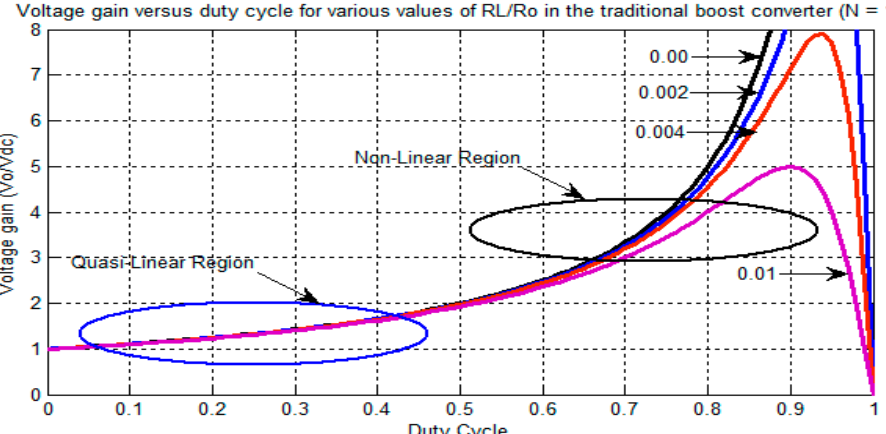
Figure 3. Duty cycle versus voltage gain of a traditional boost converter for various values of R L / Ro ( N = 1). Electronics 2018 , 7 , x FOR PEER REVIEW